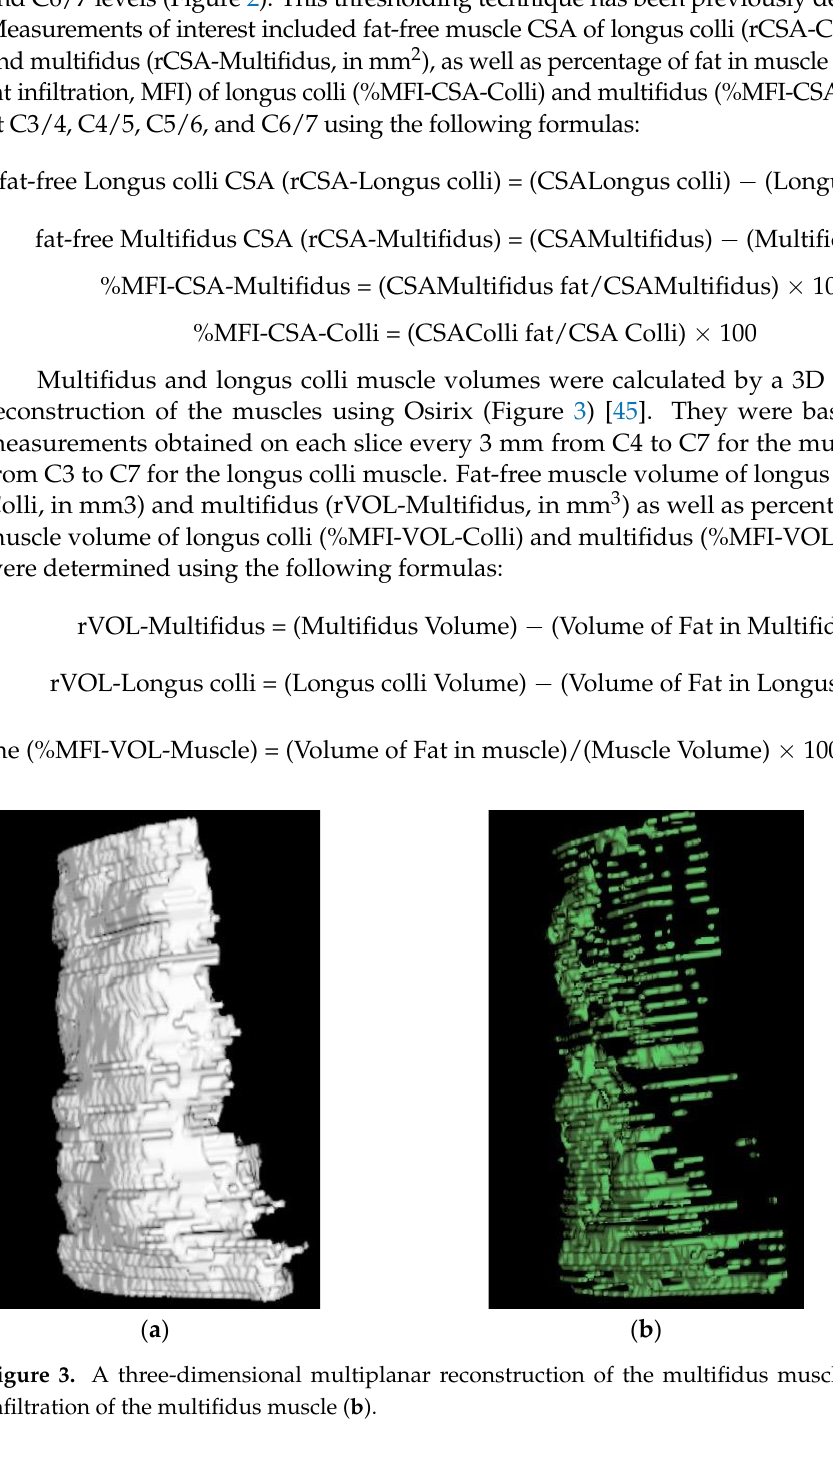
Figure 2. Measurement of cross-sectional area of the longus colli (1 and 2), multifidus (3 and 4), fat of posterior subcutaneous (5), and muscle fat infiltration (in green) at the C5-C6 level.